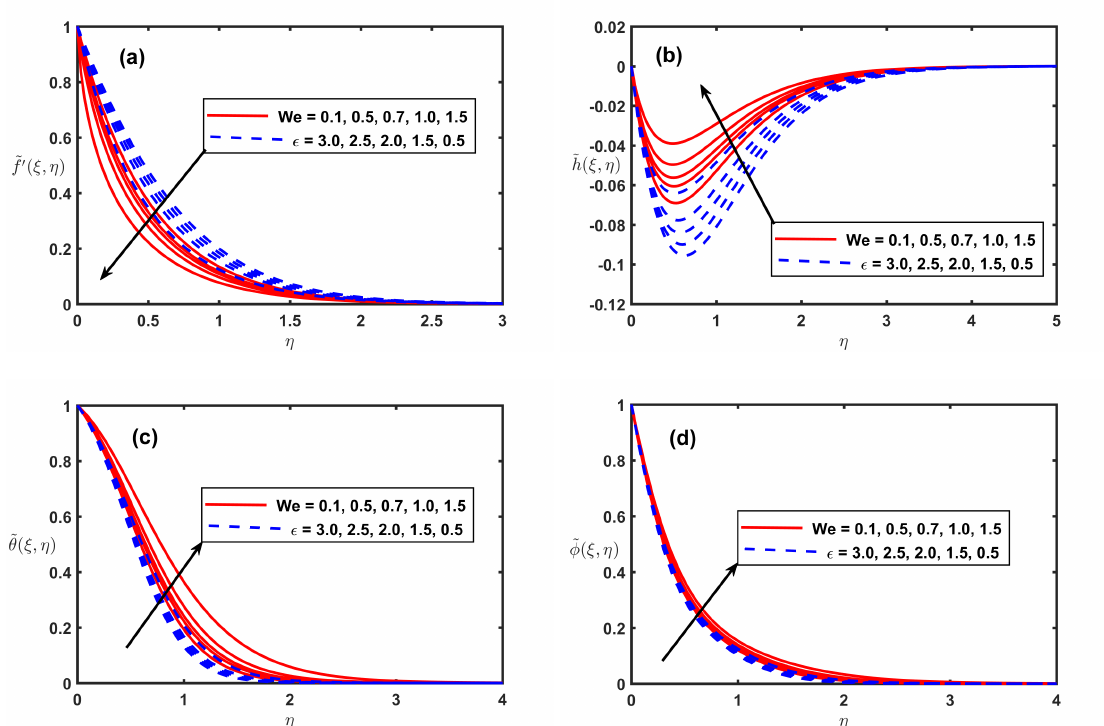
Figure 6. Fluctuation of ˜ f (cid:48) ( ξ , η ) , ˜ h ( ξ , η ) , ˜ θ ( ξ , η ) , and ˜ φ ( ξ , η ) along with We and (cid:101)